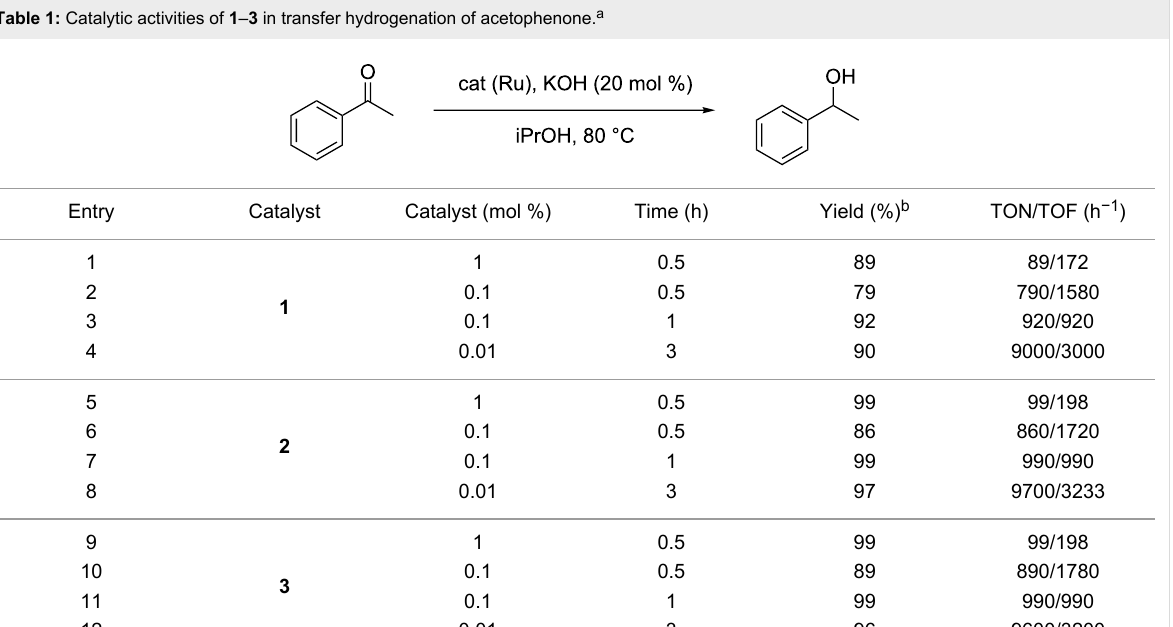
Table 1: Catalytic activities of 1 – 3 in transfer hydrogenation of acetophenone. a